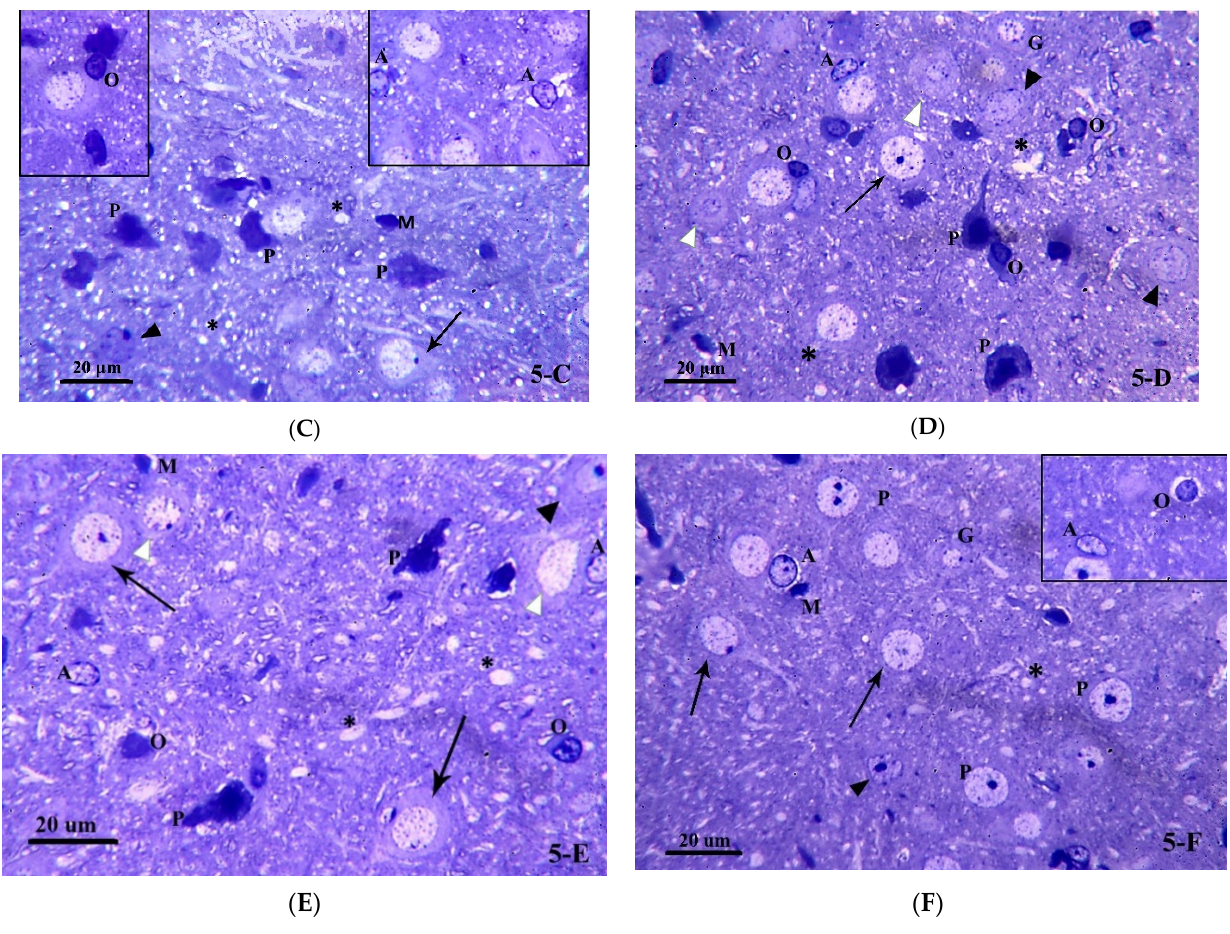
Figure 5. Photomicrograph of brain tissue semi-thin sections (toluidine blue stained) for ( A ) Group I, showing pyramidal cells (P) with large, rounded nuclei and prominent nucleoli. Granule cells (G) have small rounded euchromatic nuclei. Notice the presence of astrocytes (A), oligodendrocyte (O) and microglia (M). The neuropil is homogenous (*). ( B ) Group I, showing pyramidal cells (P) with large, rounded nuclei and prominent nucleoli. Nissl granules ( ↑ ) are seen in their cytoplasm. Notice the presence of astrocytes (A) and microglia (M). ( C ) Group II, showing most of the pyramidal cells (P) are shrunken, condensed and deeply stained. Few pyramidal cells are seen with large, rounded nuclei but with absent Nissl granules ( ↑ ). Others have large rounded dark nuclei ( ▲ ). Notice the presence of astrocytes (A) with irregular nuclei and surrounded by vacuoles, oligodendrocyte (O) and microglia (M). The neuropil is vacuolated (*). ( D ) Group III, demonstrating some pyramidal cells are shrunken, condensed and deeply stained (P). Some are seen with dark nuclei ( ▲ ) while others have large, rounded nuclei but with absent Nissl granules ( ↑ ). Some granule cells (G) have small rounded euchromatic nuclei while others have darkly stained nuclei ( ∆ ). Notice the presence of astrocytes (A), oligodendrocyte (O) and microglia (M). The neuropil is vacuolated (*). ( E ) Group IV, showing some pyramidal cells are shrunken, condensed and deeply stained (P). Some are seen with dark nuclei ( ▲ ) Some others are seen with pale, irregular nuclei ( ∆ ) while others have large, rounded nuclei but with absent Nissl granules ( ↑ ). Notice the presence of astrocytes (A), oligodendrocyte (O) and microglia (M). Notice the large vacuoles in the neuropil (*). ( F ) Group V, showing most of the pyramidal cells have large, rounded nuclei and prominent nucleoli (P). Notice the presence of Nissl granules ( ↑ ). A pyramidal cell with dark irregular nucleus is present ( ▲ ). Granule cells (G) have small rounded euchromatic nuclei. Notice the presence of astrocytes (A), oligodendrocyte (O) and microglia (M). Small vacuoles are seen in the neuropil (*). (toluidine blue × 1000).